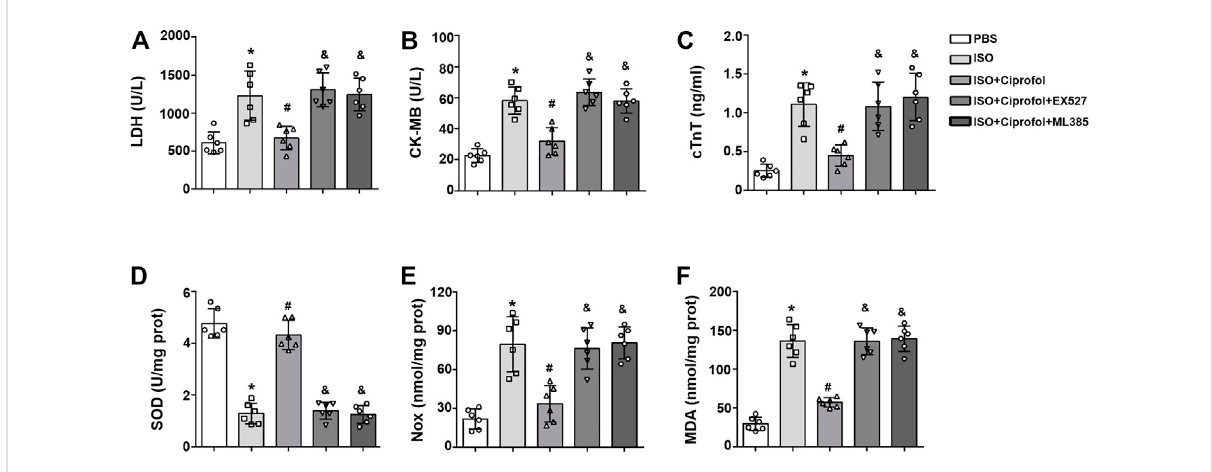
FIGURE 8 Sirt1 and Nrf2 inhibition abolished the cardioprotective and anti-oxidative stress effects of ciprofol in vitro . CK-MB (A) , LDH (B) and cTnT (C) activities in each group were detected ( n = 6). SOD (C) , NOX (D) and MDA (E) levels in each group were assessed ( n = 6). p p < 0.05 compared to the PBS group. # p < 0.05 as compared to the ISO group. & p < 0.05 compared to the ISO + ciprofol group.